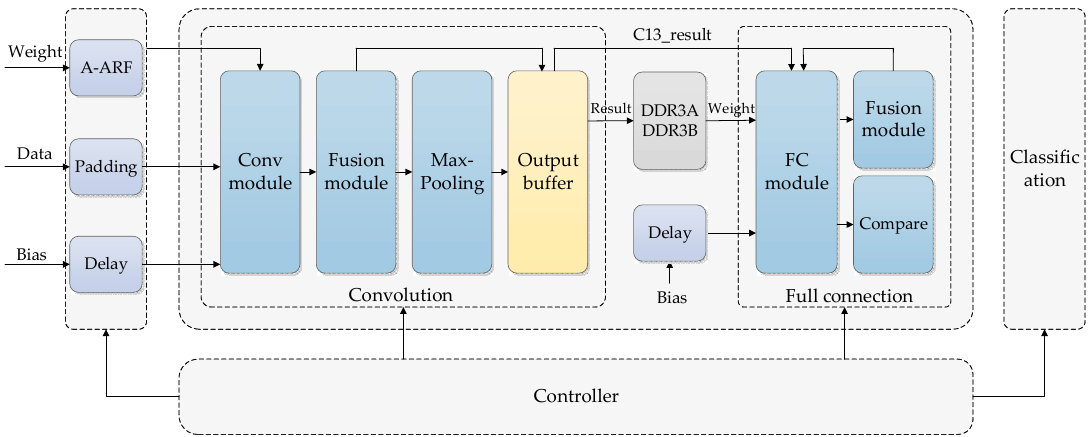
Figure 7. The hardware processing engine architecture. Conv module refers to convolution module. C13_result refers to the output of the last convolutional layer.